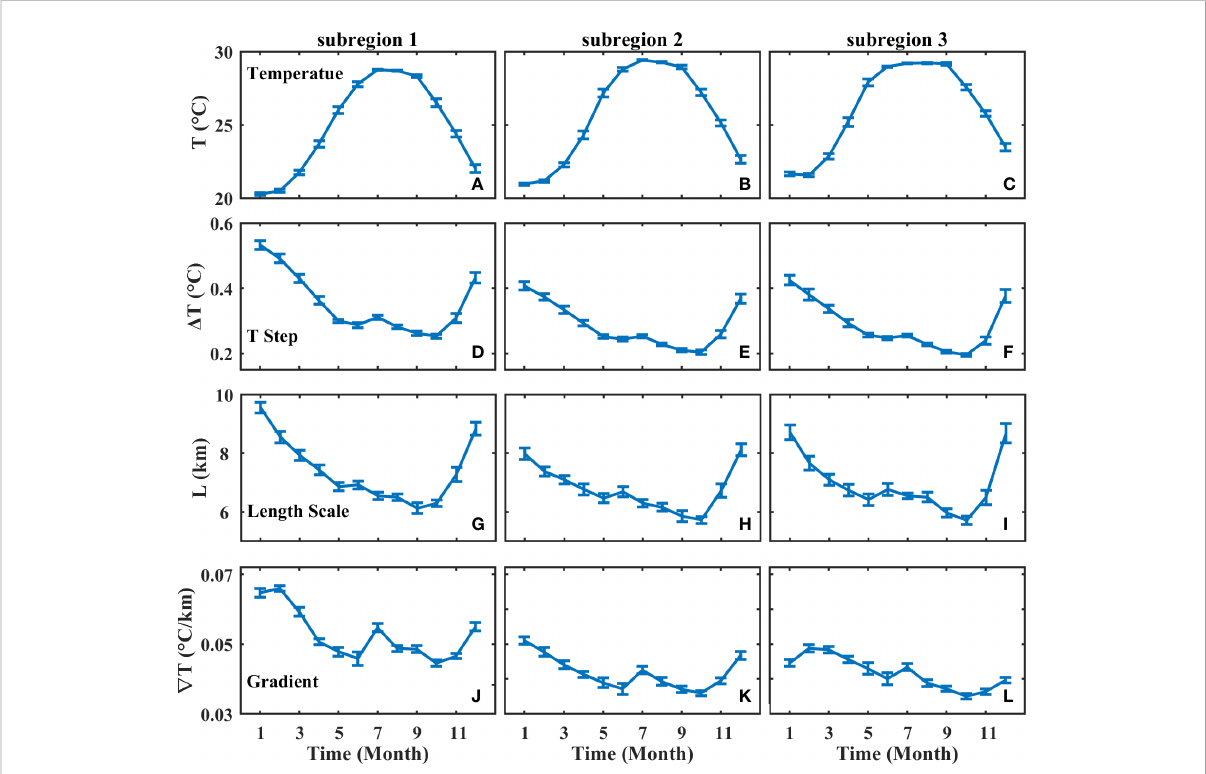
FIGURE 8 Mean monthly time series of frontal temperature (A – C) , cross-frontal temperature step (D – F) , cross-frontal length scale (G – I) , cross-frontal temperature gradient (J – L) for the three subregions averaged over 2002-2021. The error bars denote the 95% con fi dence